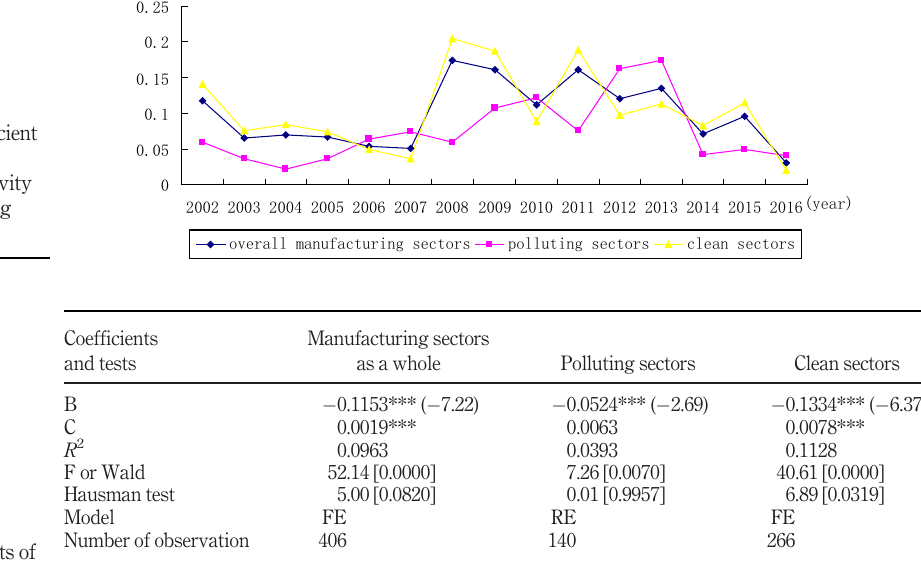
Table 4. Estimated results